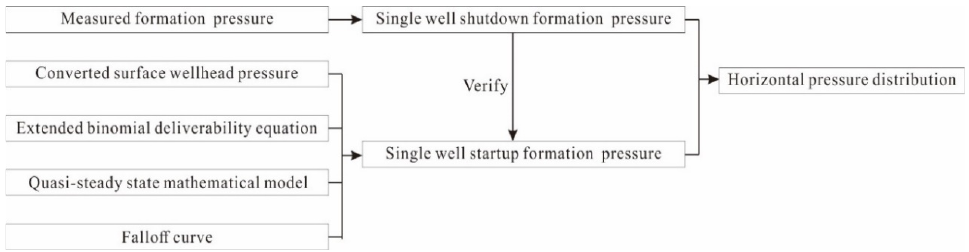
Figure 5. The evaluation technology for formation pressure measurements of shut-in gas wells. (3) Pressure-charged production technique.